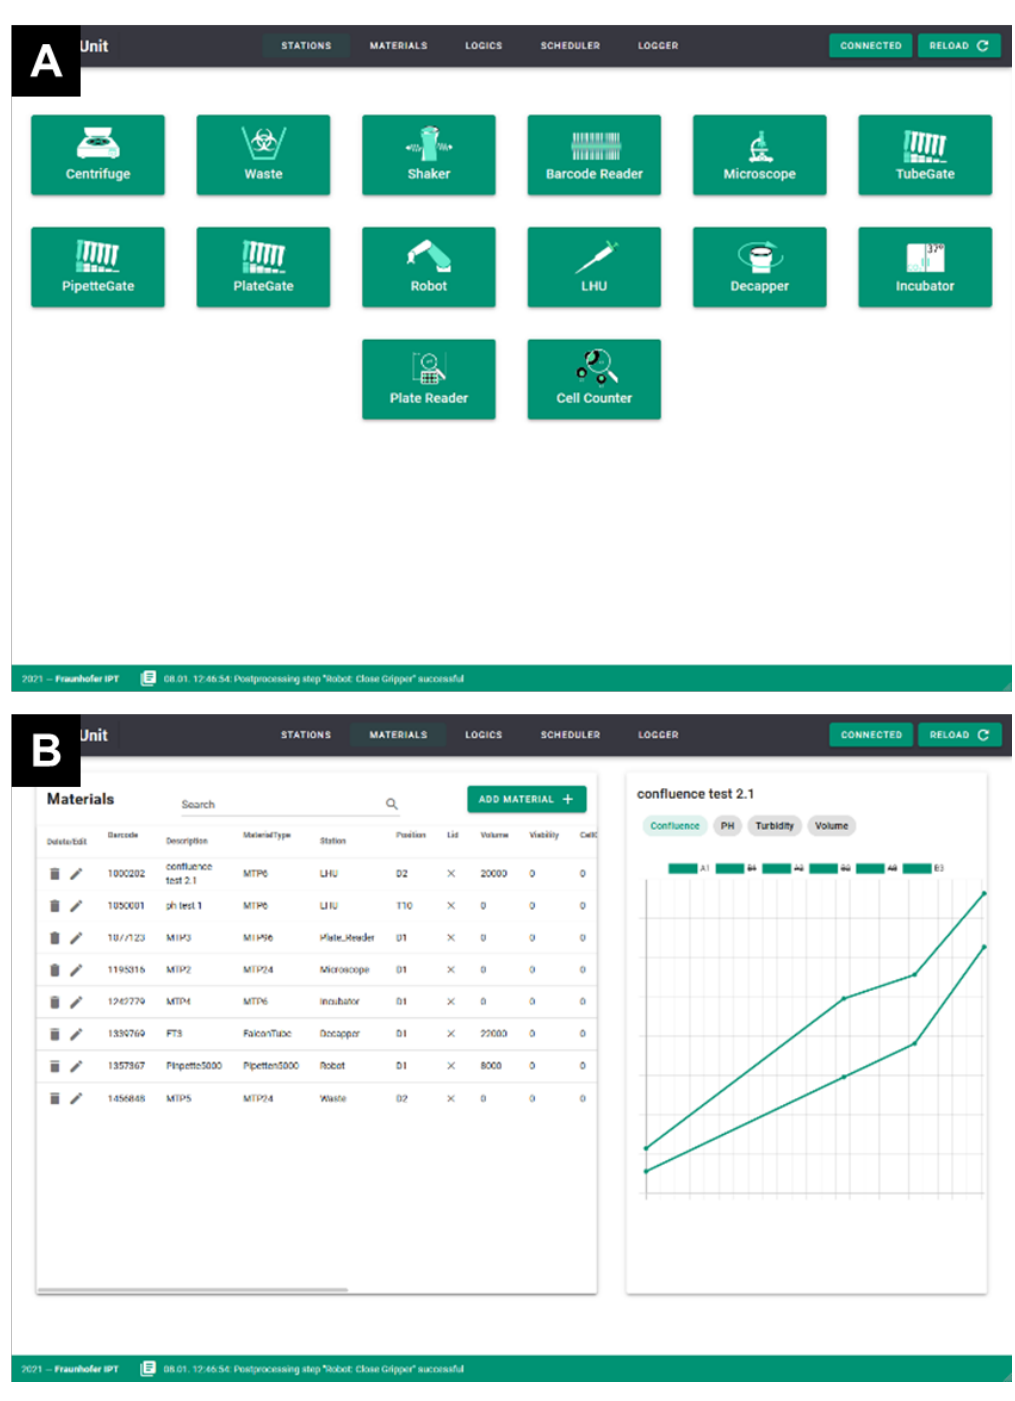
Figure 3. Screenshots of the control software with ( A ) main overview of the controllable devices in the platform and ( B ) overview of measurement results and plot options.